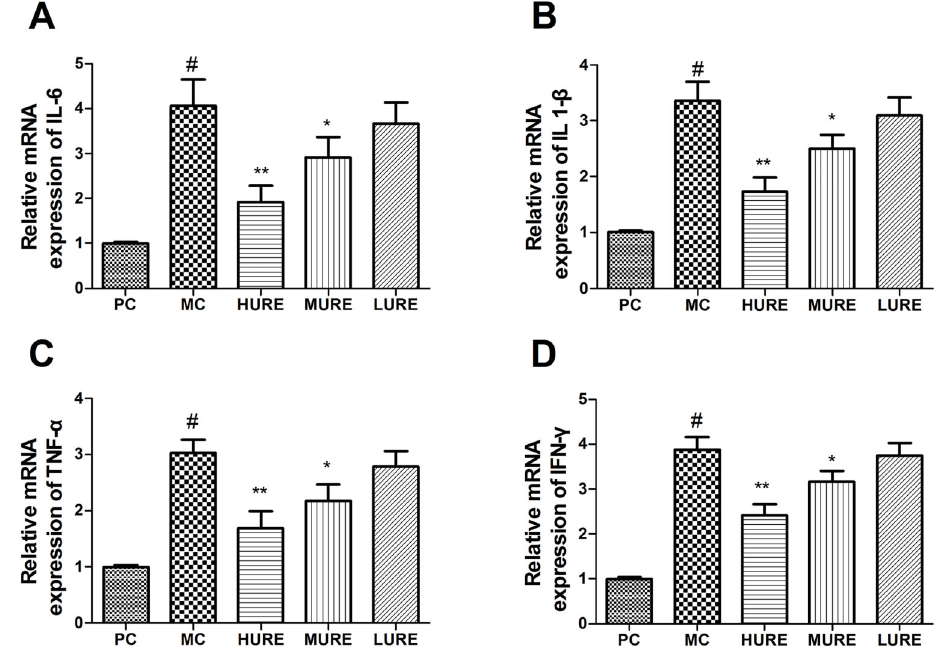
Figure 7. Relative mRNA levels of interleukin (IL)-6 ( A ), IL-1 b ( B ), tumor necrosis factor (TNF)- a ( C ), and interferon (IFN)- g ( D ) in placenta tissue determined by qPCR. Data are reported as means ± SE (n=8/group). # P o 0.01 vs the PC group, *P o 0.05 and **P o 0.01 vs the MC group (ANOVA). PC: pregnant control group; MC: LPS-treated group; HURE: LPS plus high-dose Uncaria rhynchophylla alkaloid extract (URE); MURE: LPS plus medium-dose URE; LURE: LPS plus low-dose